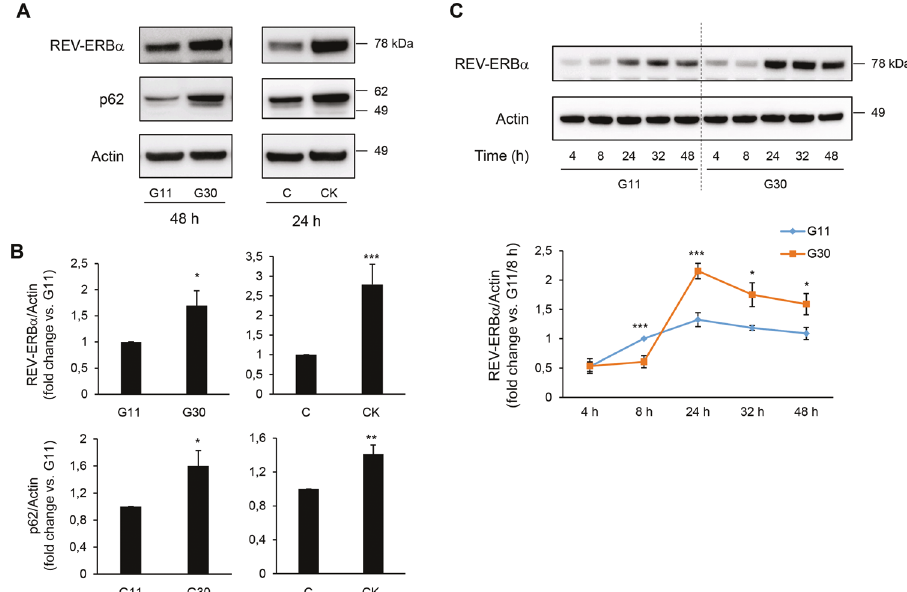
Fig. 1 Pro-diabetogenic stressors augment REV-ERB α and p62 protein expression in β -cells. A , B REV-ERB α and p62 protein levels in INS-1E cells exposed to glucotoxicity for 48 h [30 mM glucose (G30) vs. 11 mM glucose as control (G11)], or pro-in fl ammatory cytomix [CK: 10 U/ml IL- 1 β (0.2 ng/ml), 500 U/ml TNF- α (50 ng/ml) and 100 U/ml IFN- γ (33 ng/ml)] vs. control (C, 11 mM glucose) for 24 h ( n = 5 independent experiments). Graphs represent the quanti fi cation of the blots. C Temporal pro fi le of REV-ERB α expression in INS-1E cells following 48 h exposure to G30 or G11 ( n = 4 – 6 independent experiments). For all experiments, actin levels are used as loading control. Data are expressed as mean ± SEM; * P < 0.05, ** P < 0.01, *** P <